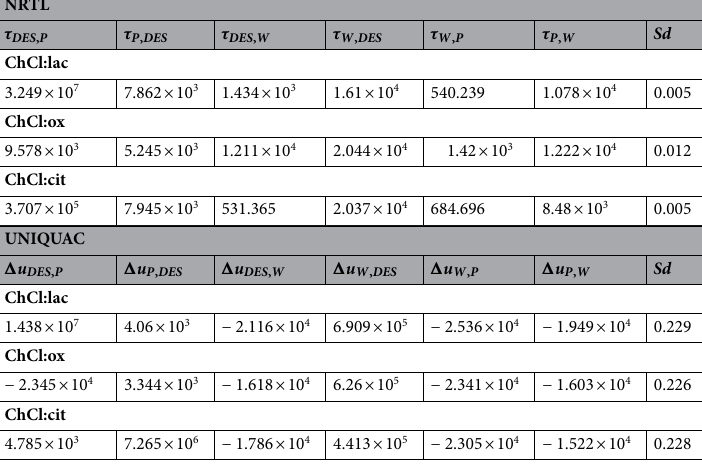
0.5 where w1 and N represented mass fraction of PPG400 and